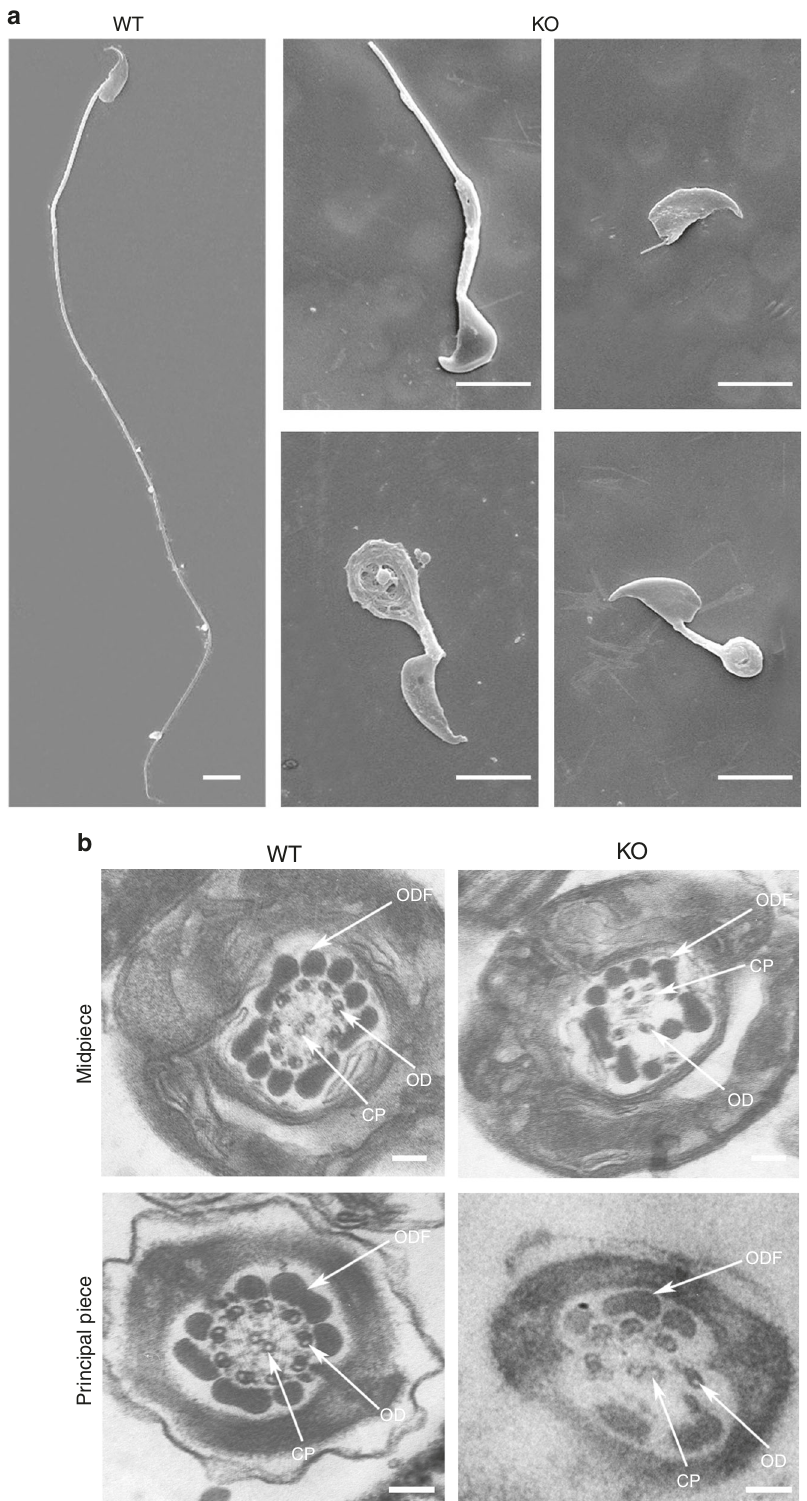
Fig. 4 Electron microscopy analysis shows the typical MMAF phenotypes in KO mice. a The MMAF phenotypes in Qrich2 -de fi cient mice by SEM (scale bars, 5 µ m). The WT mice showed a normal fl agellum, whereas the KO mice had short, coiled, or absent fl agella. b numerous defects in the sperm fl agellar ultrastructures in the KO mice. The cross-section of fl agella from KO mice presents disorganized arrangement of CP and ODF, and incomplete OD in the mid-piece. And the absence of OD and ODF were observed in the principal piece. (scale bars, 150